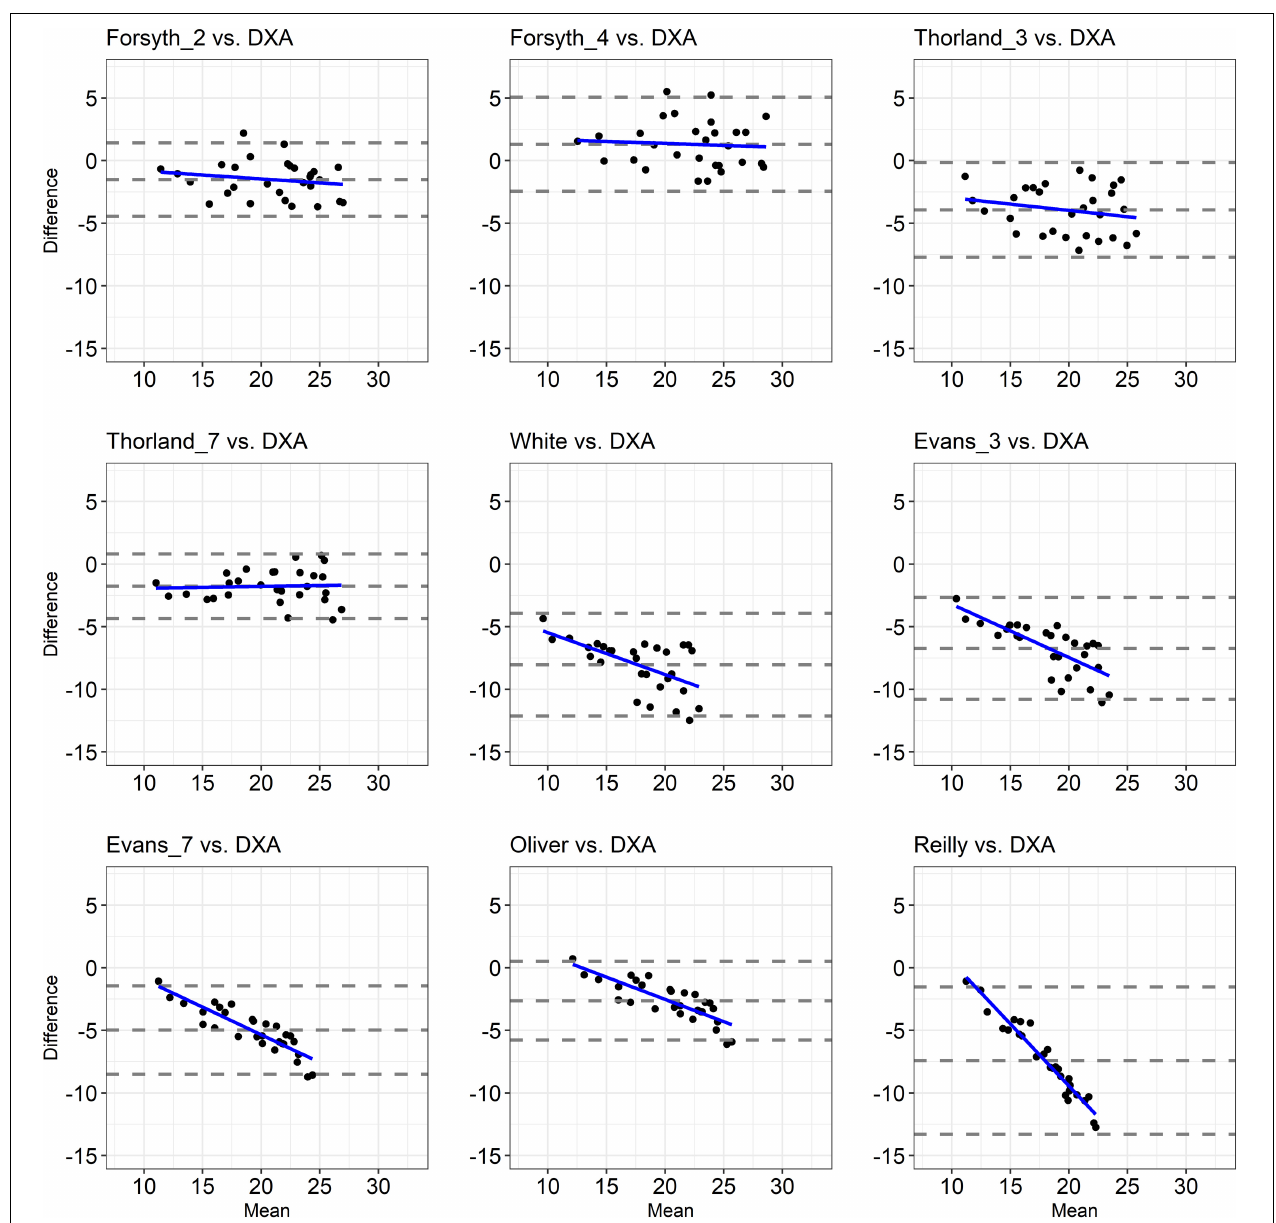
FIGURE 1 | Bland-Altman Plots showing the agreement between the %FM assessed through anthropometric equations validated upon able-bodied athletic populations and the %FM DXA . The dashed lines indicate bias ± 2 standard deviations and the solid blue line indicates the regression